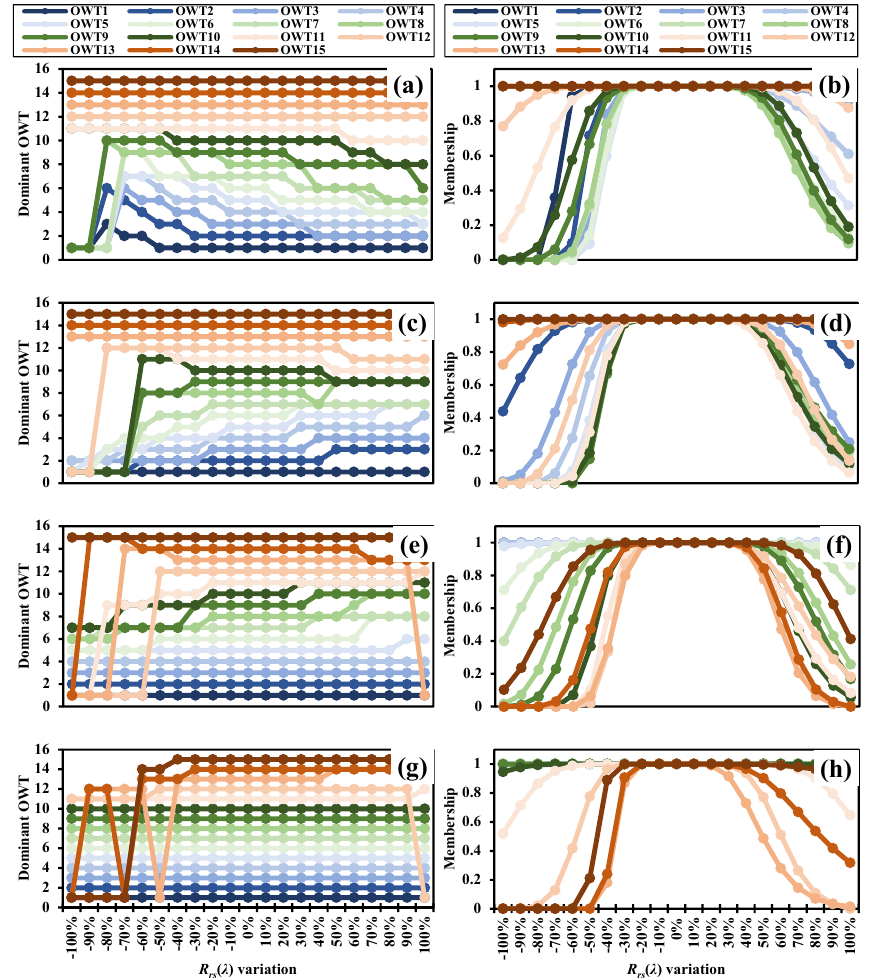
Figure 9. The U-OWT dominant OWT and membership changes in 15 OLCI mean R rs ( λ ) vectors under the variations in ( a,b ) the blue bands (400 − 500nm), ( c,d ) the green bands (500 − 600nm), ( e,f ) the red bands (600 − 700nm), and ( g,h ) the near-infrared bands (700 − 800nm). The above phenomena were also detected in the OLI and MODIS U-OWT schemes.